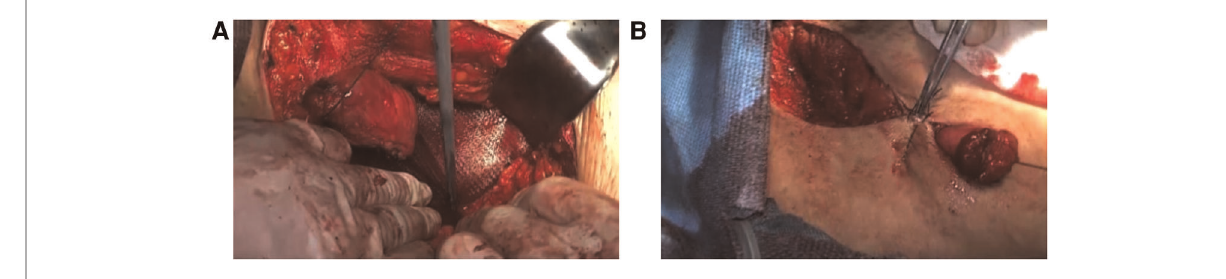
FIGURE 5 Onlay ( A ) The mesh is placed anterior to the anterior rectus sheath; ( B ) Closure of the the